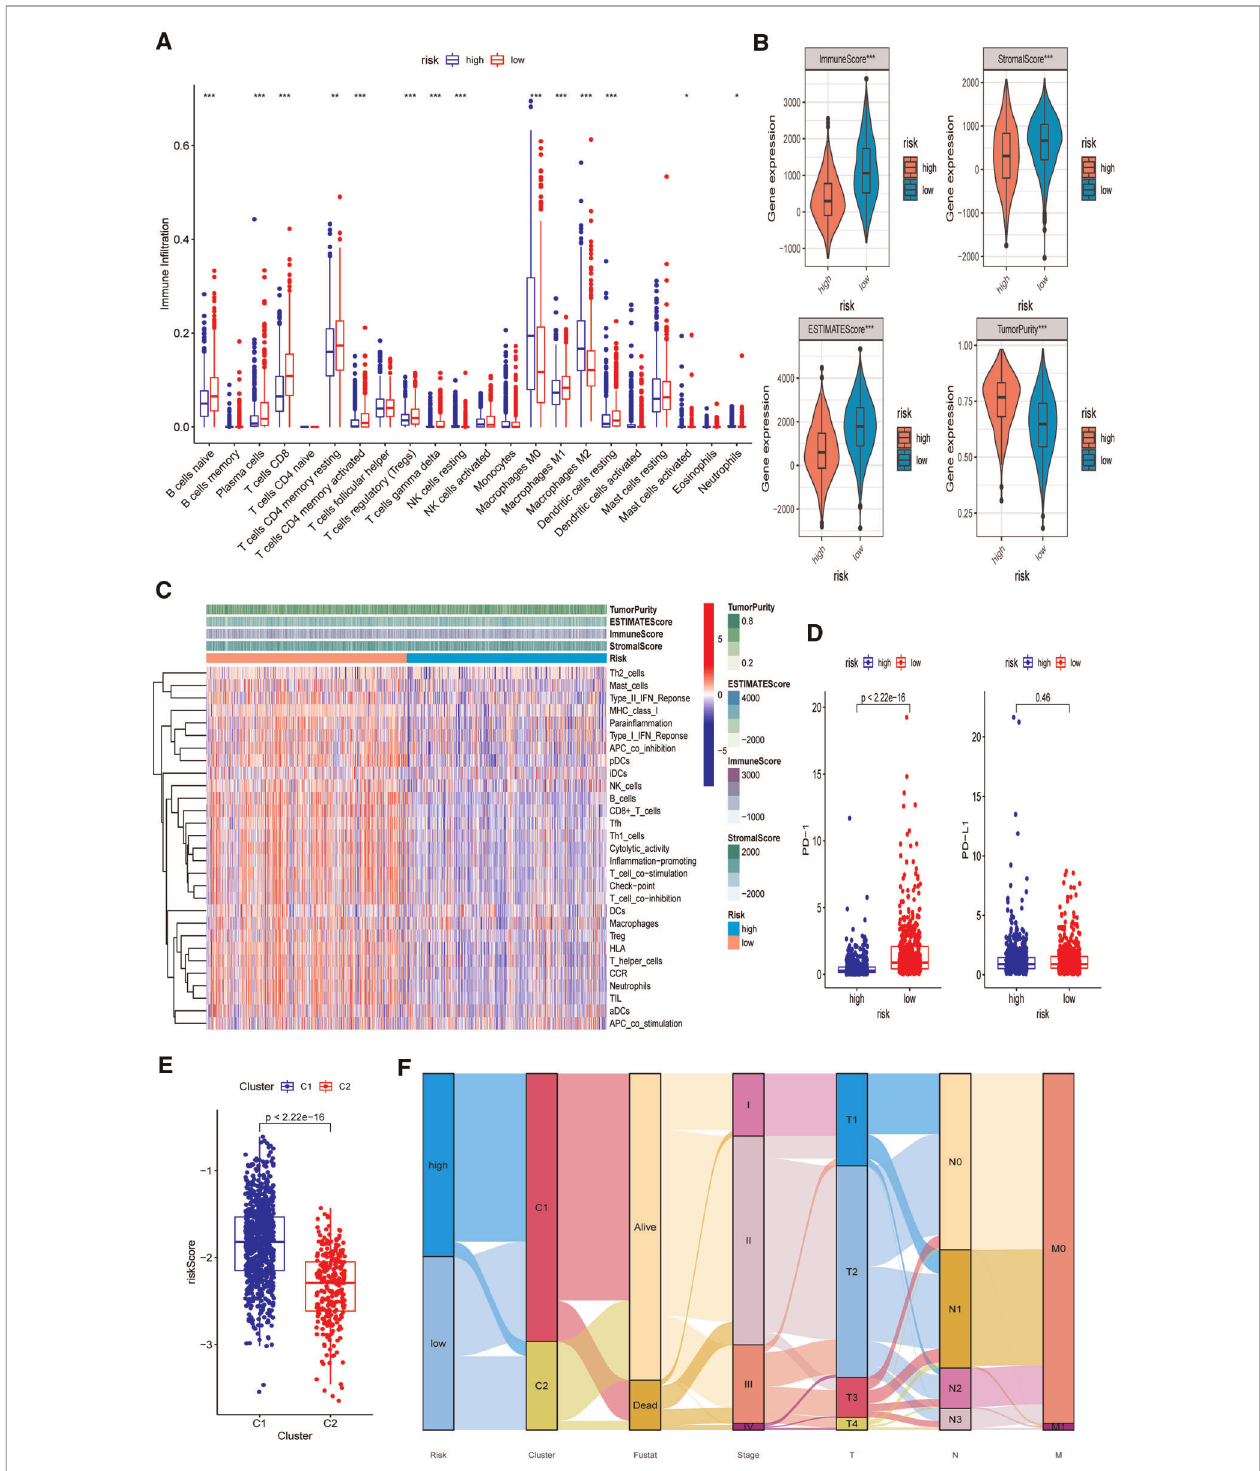
FIGURE 11 | Differences of immuno-in fi ltrative features between the two risk subgroups. ( A ) Levels of 22 immunocytes calculated with CIBERSORT in two risk subgroups. ( B ) Levels of ImmuneScore, StromalScore, ESTIMATEScore, and TumorPurtiy calculated with ESTIMATE in the two risk subgroups. ( C ) Heatmap indicating the differences in ssGSEA scores between two risk subgroups. ( D ) Expression levels of PD-1 and PD-L1 in two risk subgroups. ( E ) Associations between calculated risk scores and PR clusters. ( F ) Alluvial diagram displaying the changes in the risk score, PR clusters, survival status, cinical stage, and TNM stage in TCGA-BRCA cohort. * p <0.05, ** p <0.01, *** p <0.001, ns, not signi fi